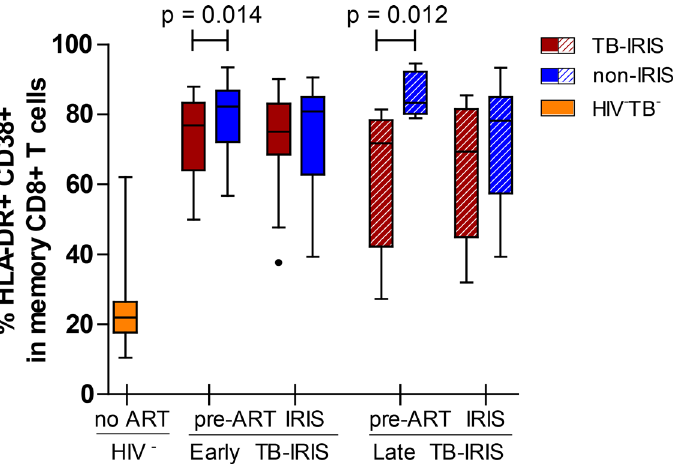
Fig 3. Percentage of activated CD8+ cells in early- and late-onset TB-IRIS patients. This box and Tukey whisker plot represents median percentages and IQR of HLA-DR+/CD38+ cells within CD8+/CD45RO+ T cells for early- and late-onset TB-IRIS patients (red) compared to non-IRIS (blue) controls. Median values and IQR for 16 HIV-TB- (yellow) controls are also represented. Full lines above indicate significant differences between paired patients (Wilcoxon signed-rank test). The level of significance was set to P < 0.05 for all tests. Number of patients (and paired non-IRIS controls) prior to ART were; 18 for early-onset TB-IRIS and 8 for late-onset TB-IRIS. Number of patients (and paired non-IRIS controls) during IRIS event or corresponding control time point were; 16 for early-onset TB-IRIS and 9 for late-onset